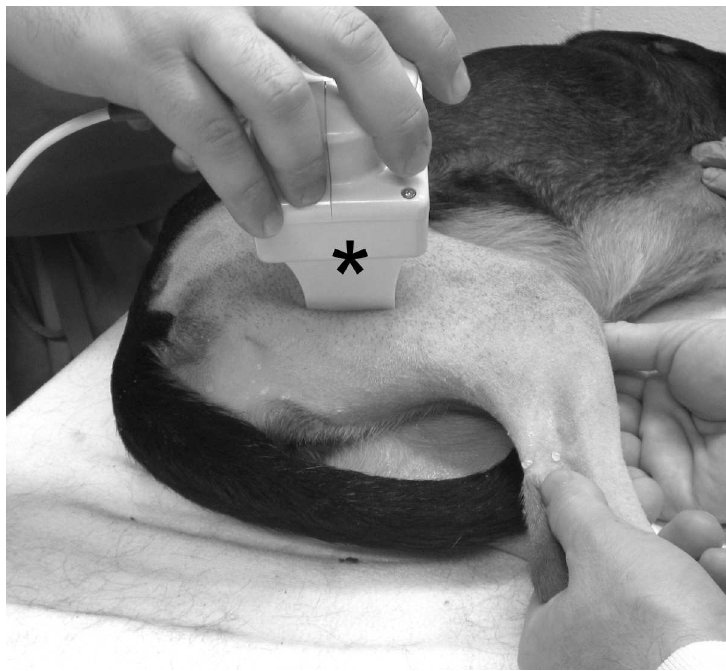
Fig 1. EIM assessmentin dogs. The photomicrographillustrates the placementof the EIM device on the biceps femoris muscle of an experimental subject. Asterisk, the EIM device used in the assay.